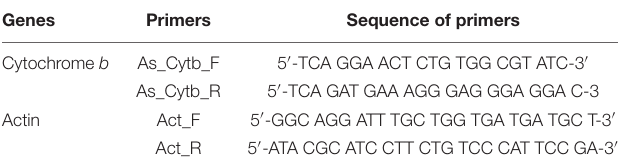
TABLE 2 | Primers to quantify fungal load ( Alternaria solani ) by